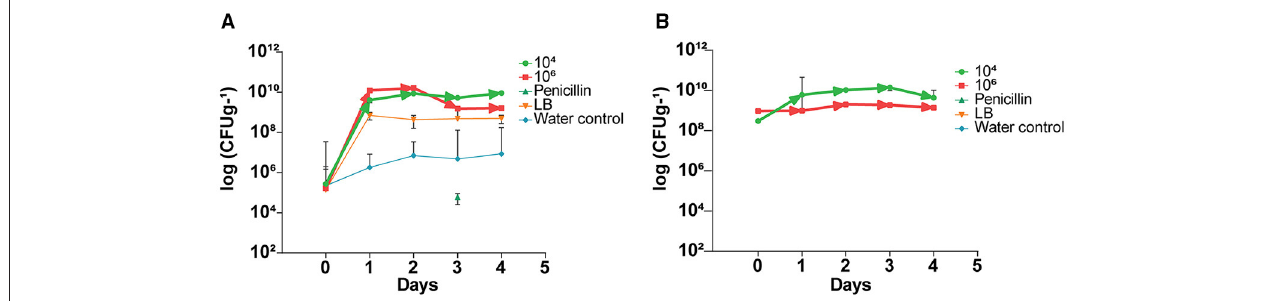
FIGURE 2 | Elevation of indigenous endophytes derived after application of B. subtilis L1-21 in citrus half-leaf method. (A) Native endophytes density in the diseased citrus leaves after application of endophytes and penicillin and negative control. (B) Recovery of treated endophytes from the diseased citrus leaves during different time intervals with different treatments. The populations of endophytic bacteria were calculated based on the average logarithm (base 10) of bacteria recovered from the plant leaves. The detection limit (1 × 10 2 cfu leaves − 1 ) was treated as log 0 for mean calculation. The log cfu values were analyzed with the GraphPad Prism version 8 (San Diego, California, USA). The values are means ± SD of five replicated experiments.